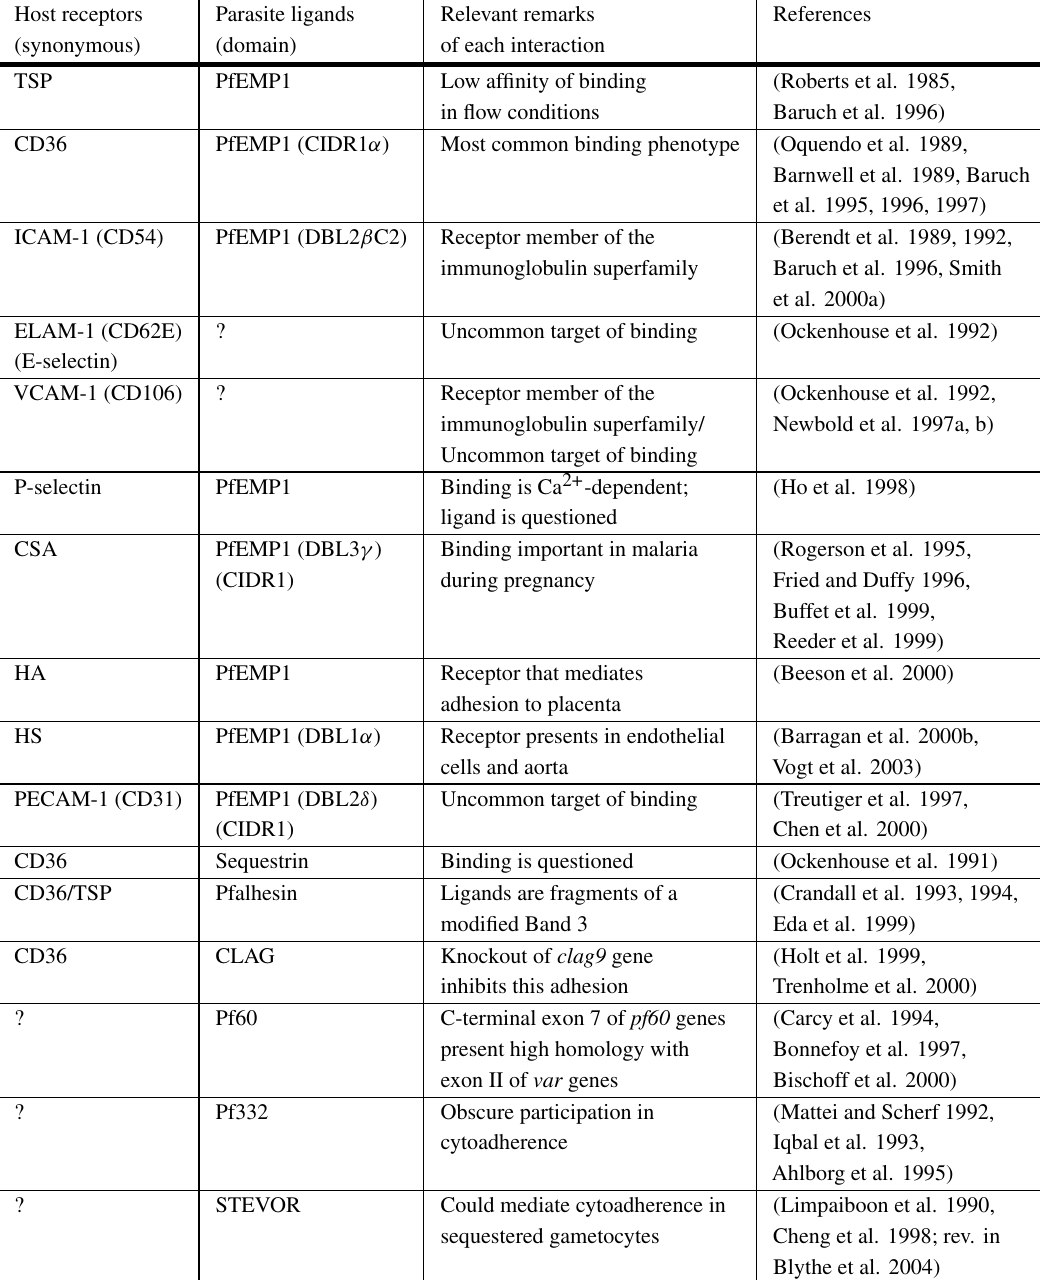
Host receptors and parasite ligands involved in cytoadherence. Host receptors: TSP (thrombospondin), CD36 (cluster of differentiation 36), ICAM-1 (intercellular adhesion molecule 1), ELAM-1 (endothe- lial leukocyte adhesion molecule 1), VCAM-1 (vascular cell adhesion molecule 1), CSA (chondroitin- 4-sulfate), HA (hyaluronic acid), HS (heparan sulfate), PECAM-1 (platelet-endothelial cell adhesion molecule 1). Parasite ligands: PfEMP1 ( P. falciparum erythrocyte membrane protein 1). Domains: DBL (Duffy binding-like), CIDR (cysteine rich interdomain region). CLAG (cytoadherence-linked asexual gene). STEVOR (subtelomeric variant open reading